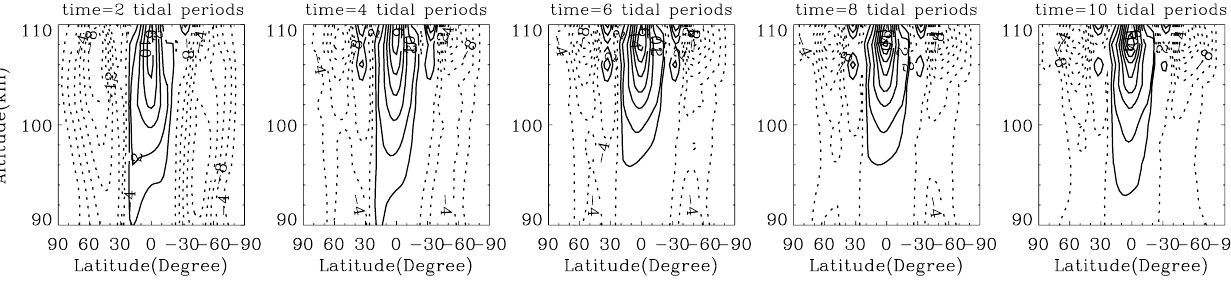
Fig. 8. Temporal evolution of the zonal-wind amplitude difference within 10 tidal periods for March deduced from the nonlinear propagation solution of the migrating semidiurnal tide starting from zero tidal oscillations. The intervals of the contours are 2ms − 1 . The solid and dotted curves denote the positive and negative values,